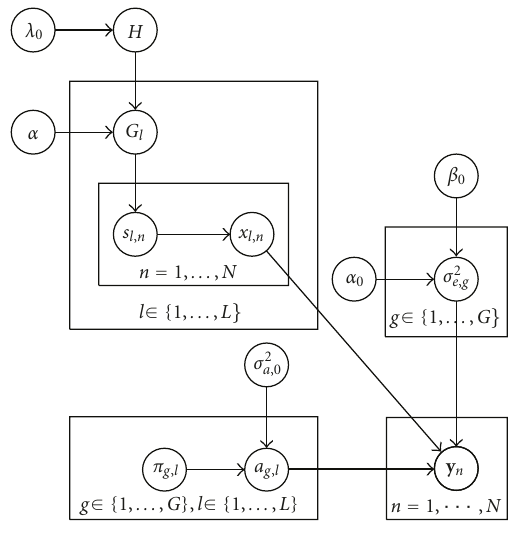
Figure 1: Graphical